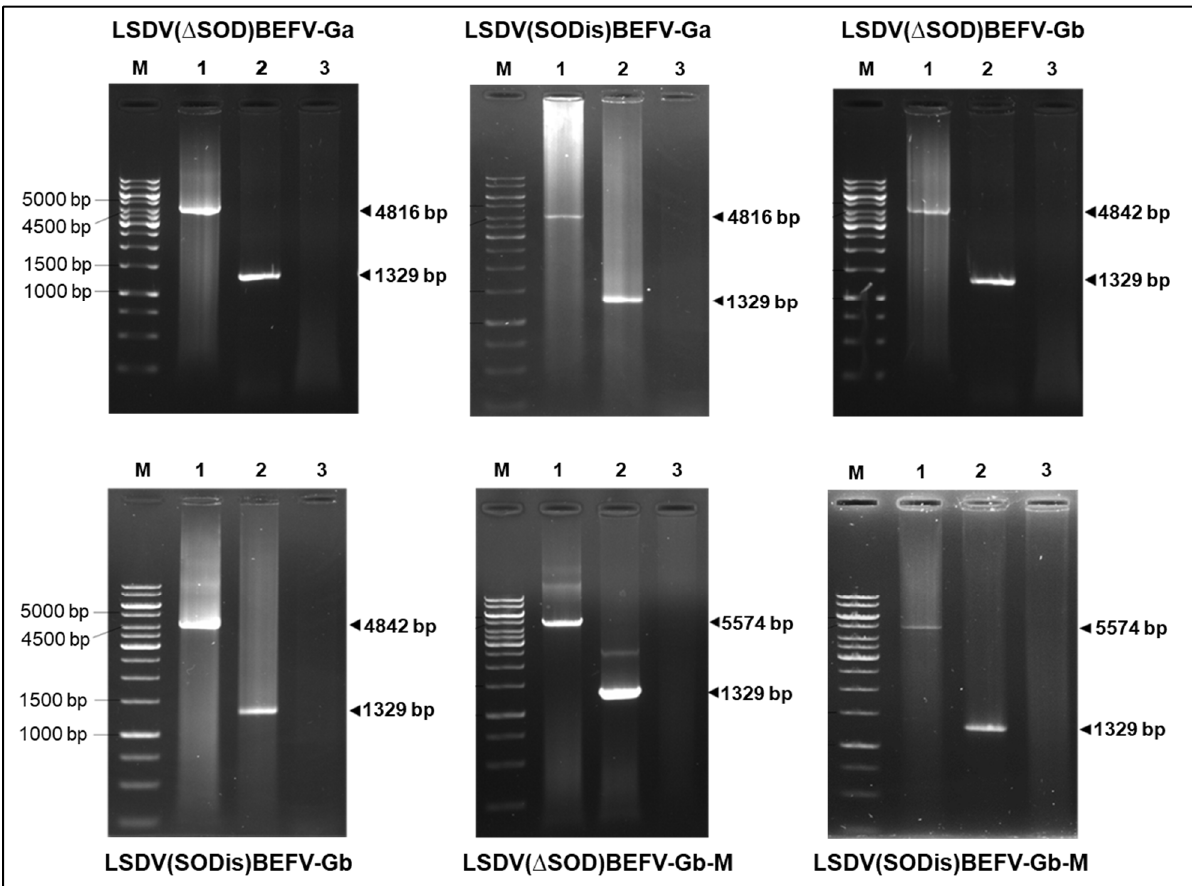
Figure 3. PCR confirmation of the recombinant LSDV-BEFV candidate vaccines. DNA was extracted from infected MDBK cells and subjected to PCR using forward (for) and reverse (rev) primers as indicated in Figure 2. Fragments were separated by electrophoresis on 0.8% agarose gels. M—GeneRuler 1 kb DNA Ladder (Thermo Fisher Scientific), lanes 1 = vaccine of interest, as labelled above or below the images; lanes 2 = parent LSDV (nLSDV ∆ SOD-UCT or nLSDVSODis-UCT) and lanes 3 = uninfected cells.